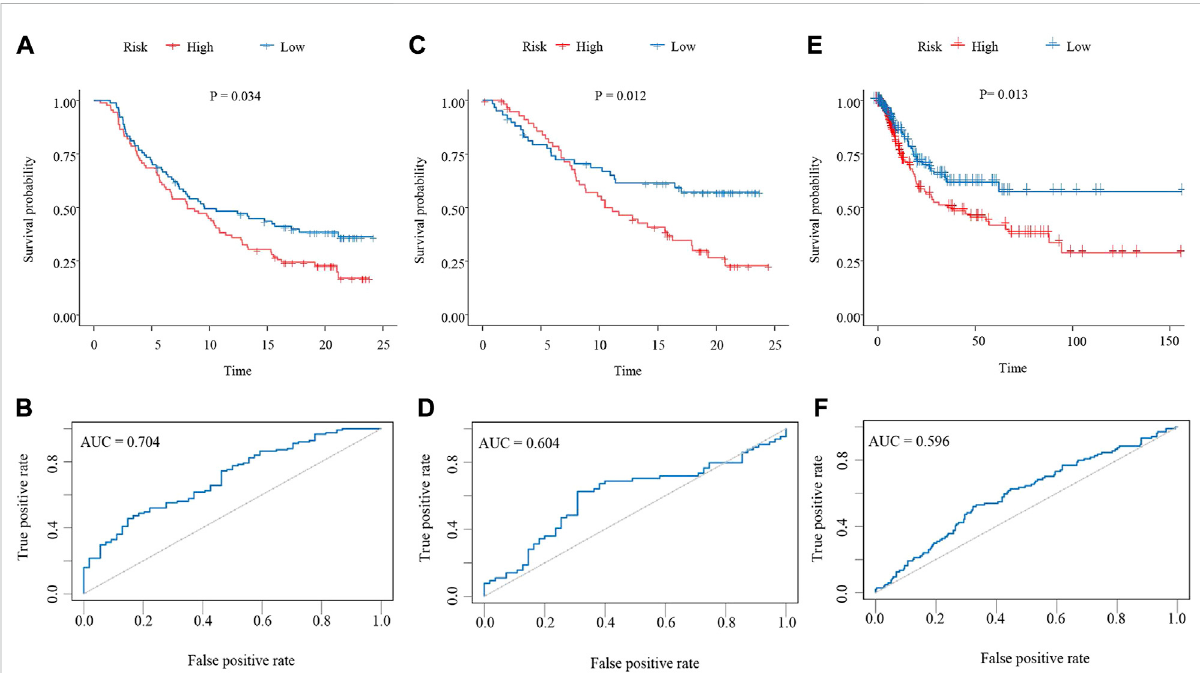
Validation of the neutrophil-based prognostic model (A,C,E) Kaplan – Meier survival curves of bladder cancer patients from the high-risk group andthelow-riskgroup. (A) ,trainingdataset( p =0.034,HR=1.309,95%CI:1.019 – 1.682). (C) ,internalvalidationdataset( p =0.012,HR=1.578,95%CI: 1.101 – 2.262). (E) ,externalvalidationdataset( p =0.013,HR=1.425,95%CI:1.076 – 1.889). (B,D,F) ROCcurvesevaluatingthesensitivityandspeci fi city of the neutrophil-based prognostic model. (B) , training dataset. (D) , internal validation dataset. (F) , external validation dataset. ROC, receiver operating